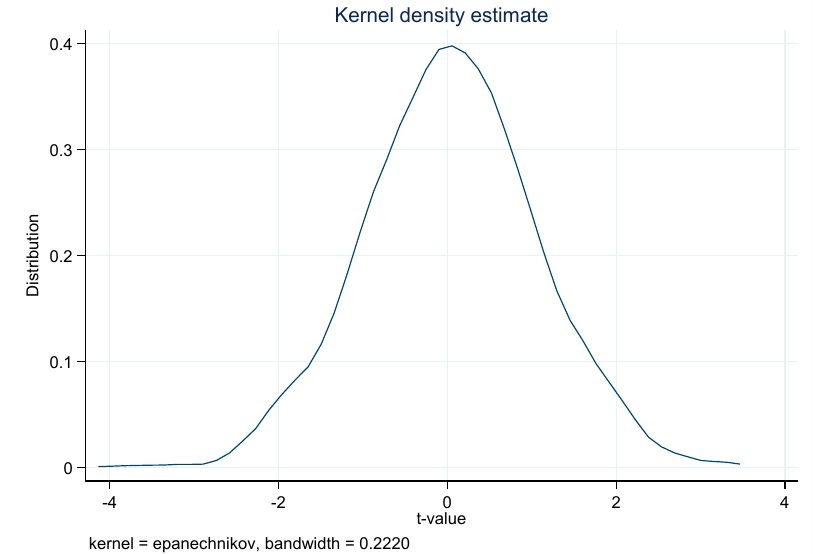
Figure 3. Placebo test ( AQI ).